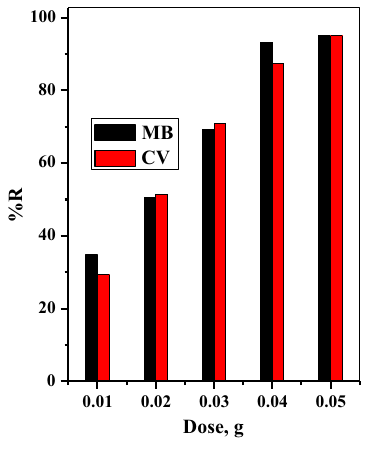
Fig. 6 Effect of m-Biochar dose on removal percent of MB and CV dyes from pure water. MB → [MB] = 60 ppm, T = 25 °C, pH = 7, t = 10 min, V = 50 ml; CV → [CV] = 40 ppm, T = 25 °C, pH = 7, t = 10 min, V = 50 ml